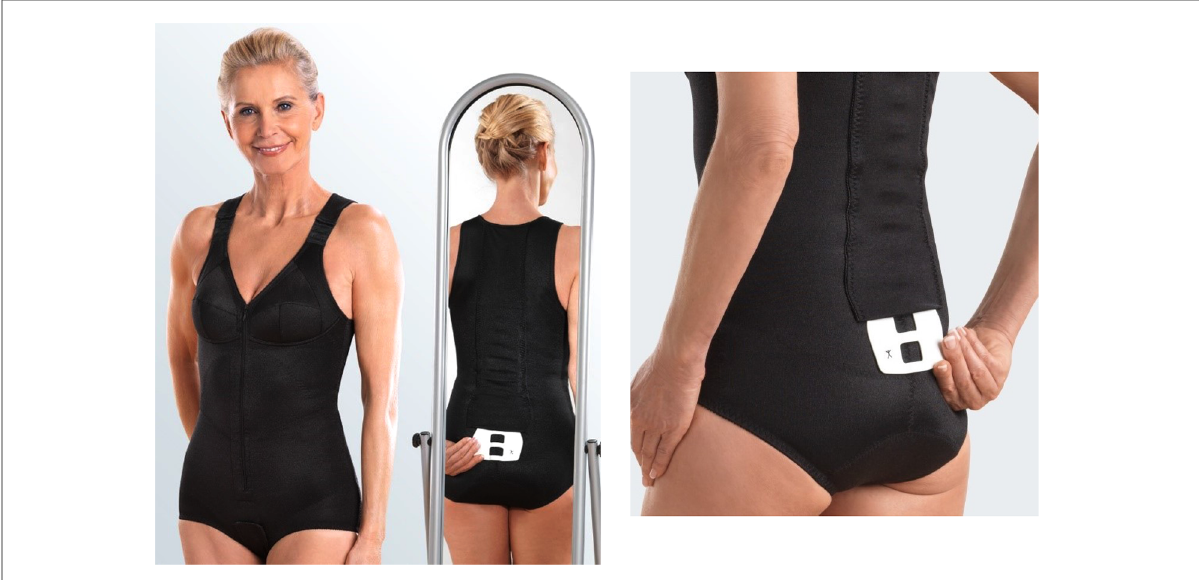
FIGURE 2 “ Spinomed active ” back orthosis. Picture provided and authorized by medi GmbH&Co. KG (Bayreuth,